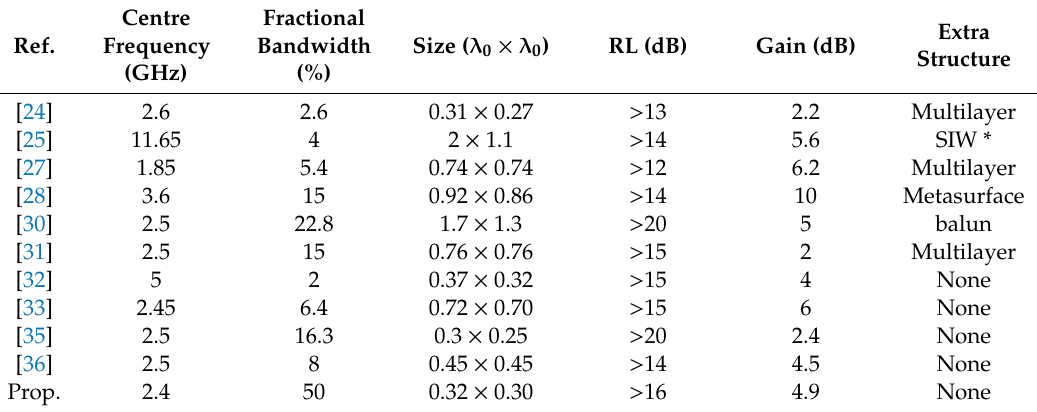
Table 4. Comparison between the proposed design and others.